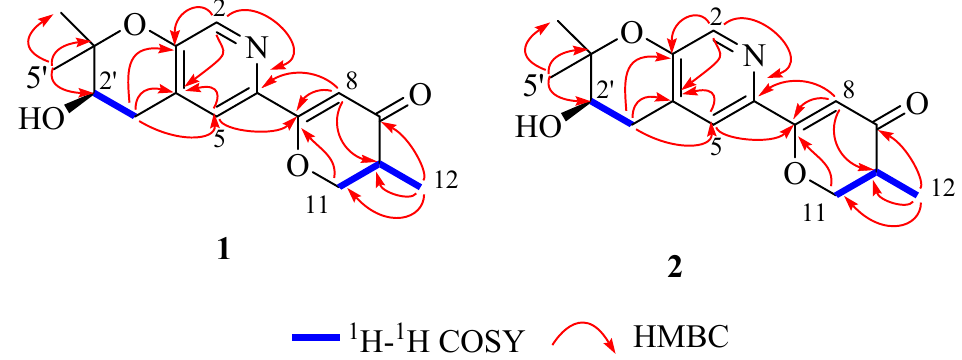
Figure 3. Key 1 H- 1 H COSY and HMBC correlations of compounds 1 and 2 .